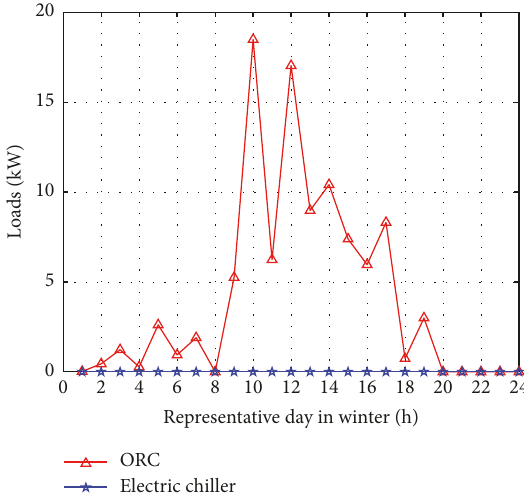
Figure 14: Hourly outputs of the EC and ORC in a winter day.